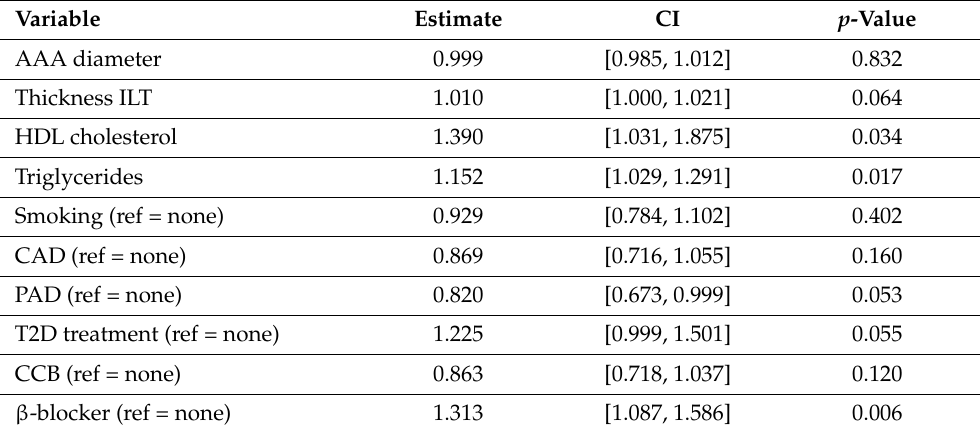
Table 4. Plasma sCD163 concentrations and associations with the AAA